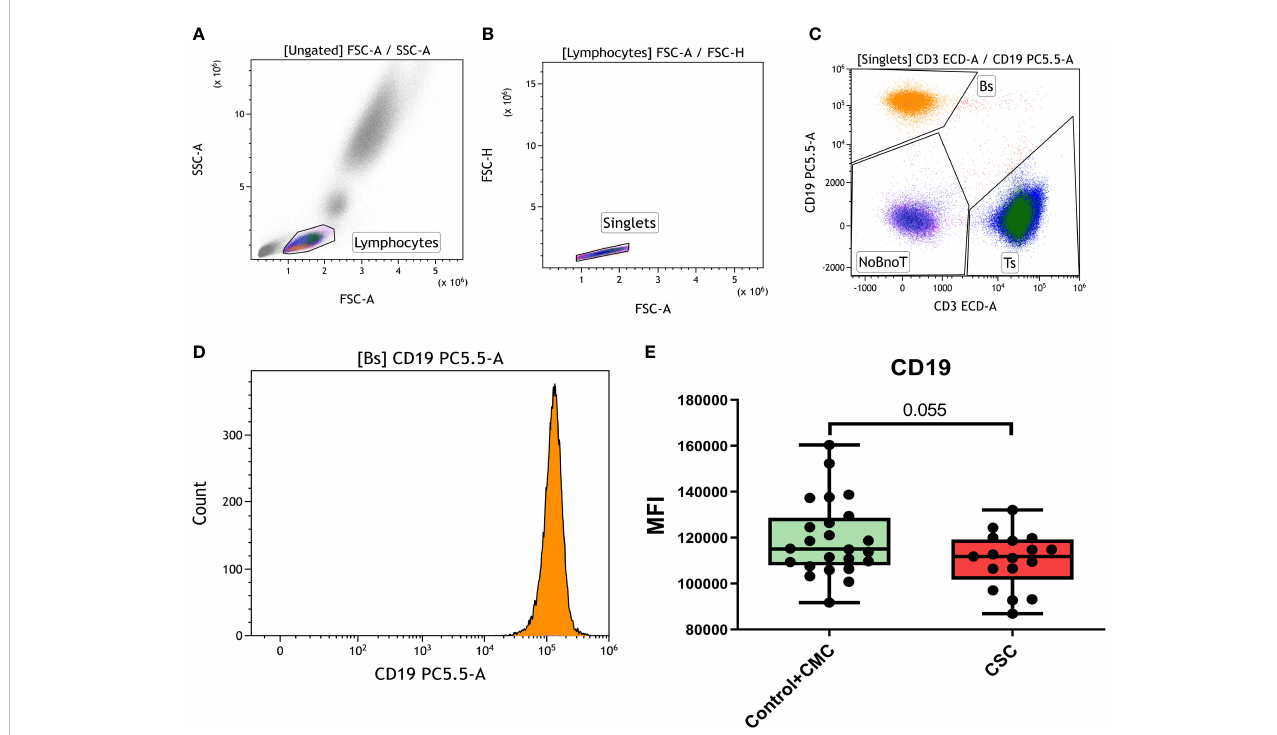
FIGURE 3 Expression of CD19 in B lymphocytes. (A) Selection of lymphocytes by forward and side scatter. (B) Selection of single events. (C) Determination of general lymphocyte populations by CD3 and CD19 and gating of the CD19 + population. (D) Median fl uorescence intensity (MFI) of CD19 in B cells. (E) Differences in CD19 expression measured as MFI in the Control+CMC group and in CSC participants. CMC/CSC: convalescent of mild/severe COVID-19 individuals. Boxes represent the 25 and 75% quartiles, lines represent the median of the distribution, and whiskers are the maximum and minimum values of the